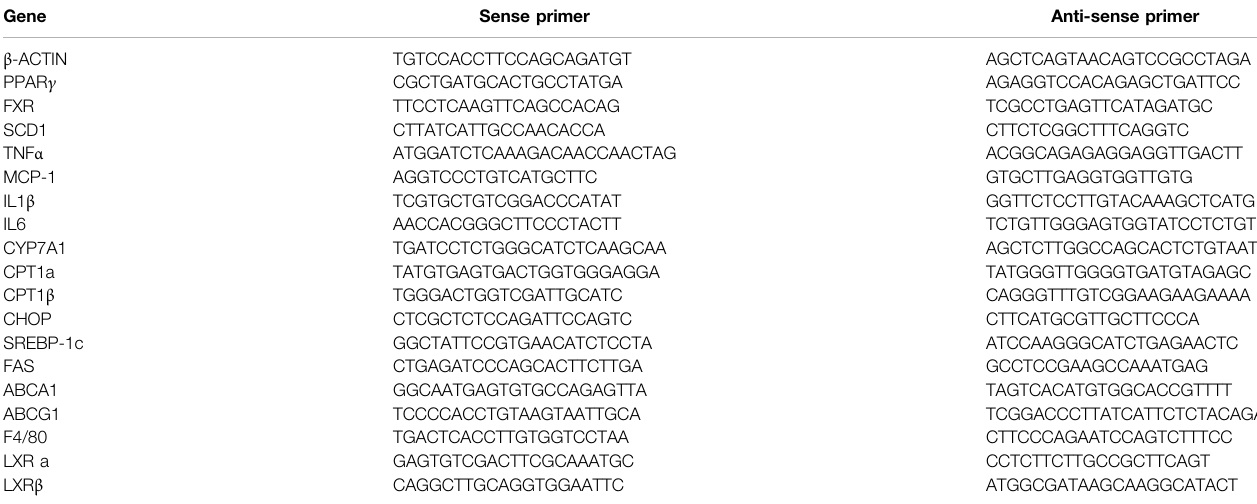
TABLE 1 | Sequences of the mouse primers used in real time PCR.